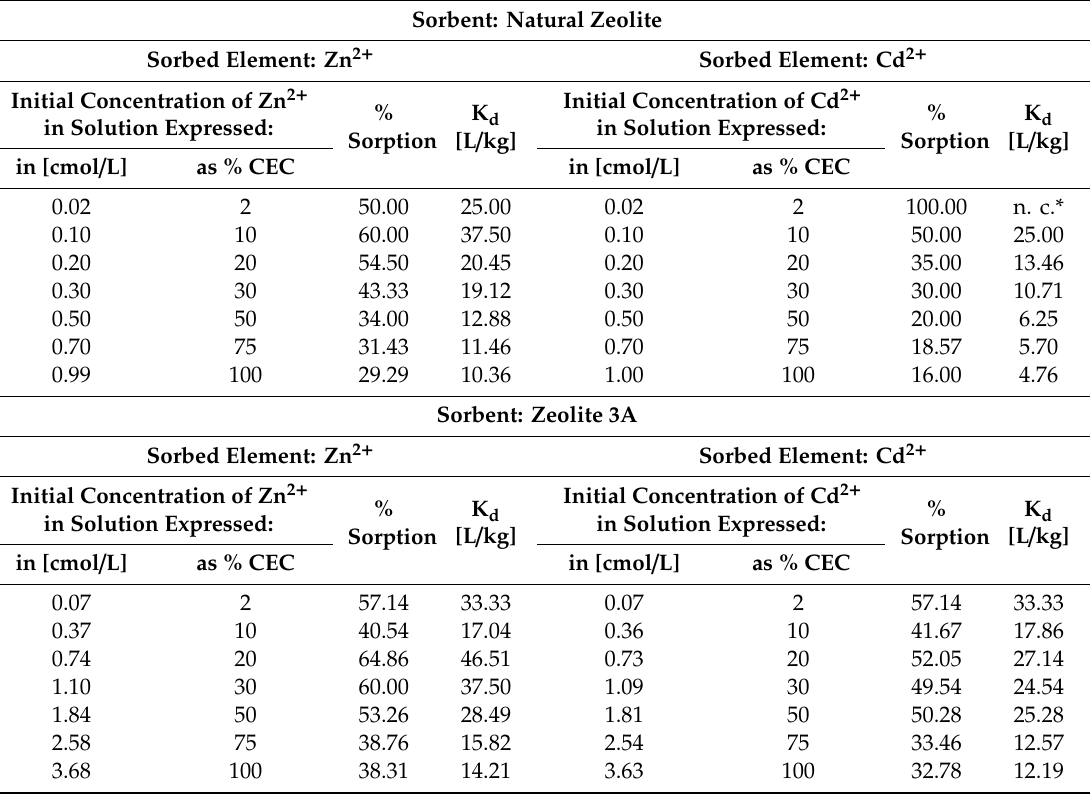
Table 2. The results of the examination of sorption of Zn 2 + and Cd 2 + onto tested zeolites, % sorption, and K d